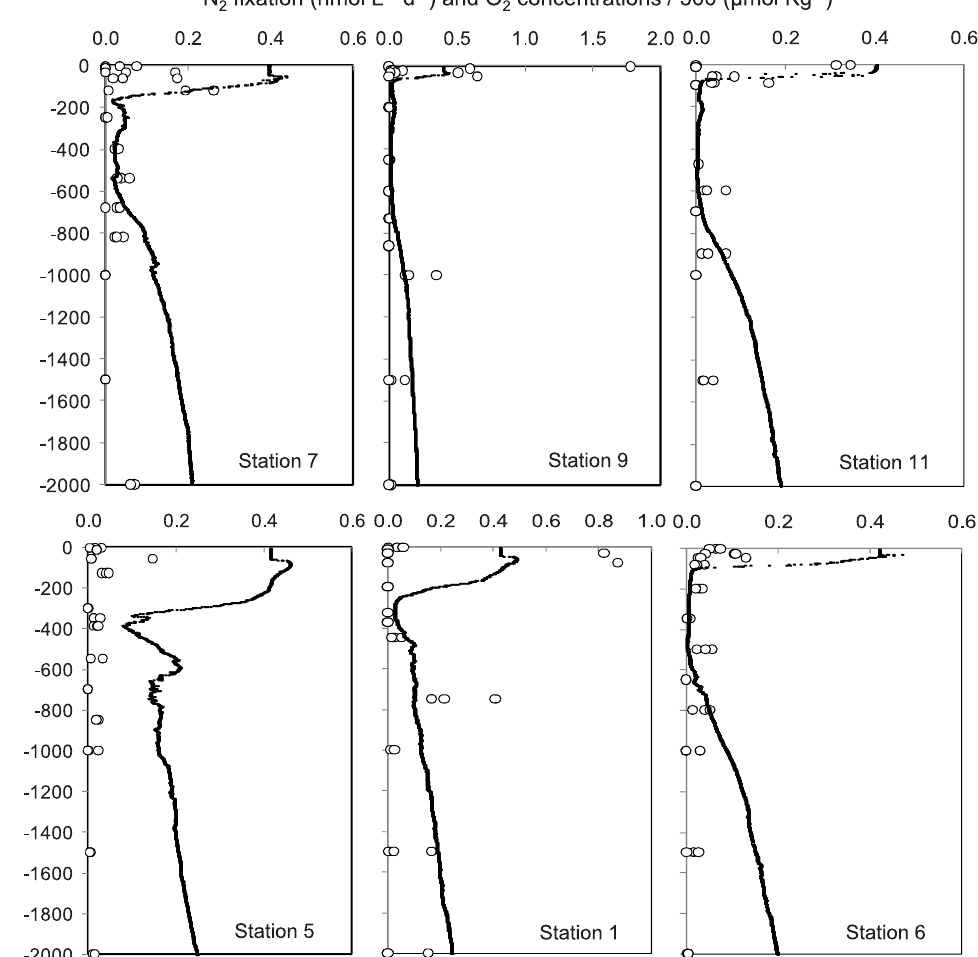
Figure 6. Vertical profiles (0–2000 m) of N 2 fixation rates (nmol L 2 1 d 2 1 ) during the 2011 cruise (R/V Melville). Open circles: individual N 2 fixation measurements at each depth. Black line: dissolved oxygen concentrations ( m mol Kg 2 1 ) divided by 500 to fit on the same scale.